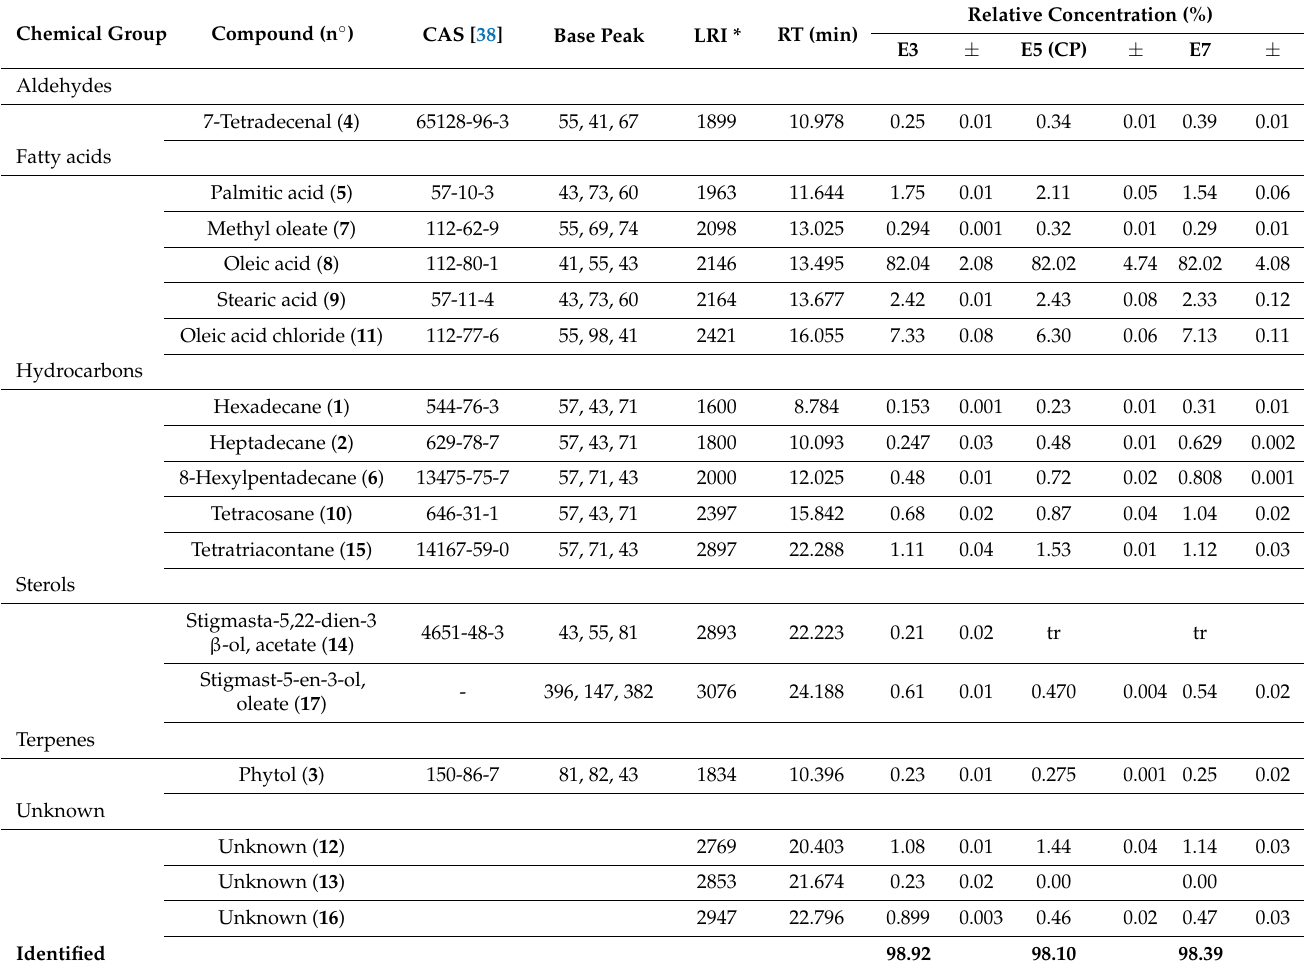
Table 3. Chemical composition of SFE-CO 2 extracts obtained from Mo seeds analysed by